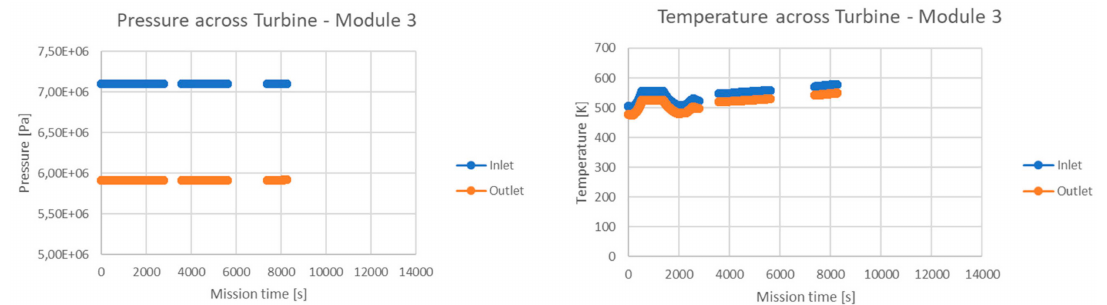
Figure 17. Pressure and temperature trends across hydrogen turbine for the three TMS modules.